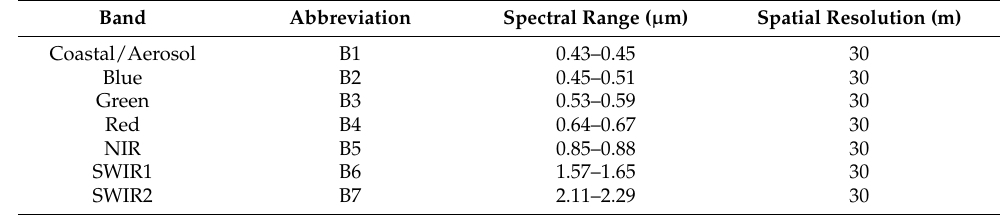
Table 1. Wavelengths and spatial resolutions for Landsat 8 OLI data.